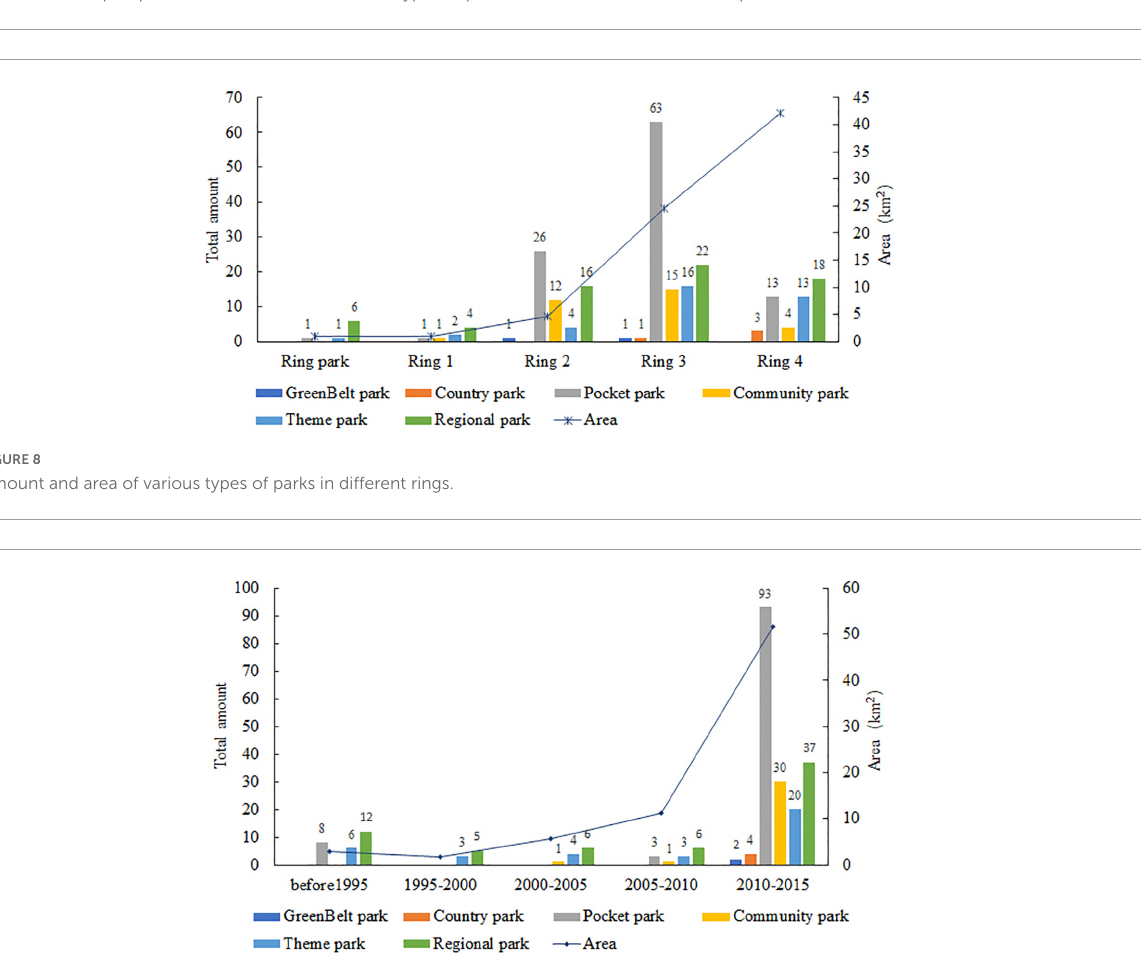
FIGURE7 Distribution map of parks: (A) Distribution of various types of parks. (B) Historical distribution of parks.